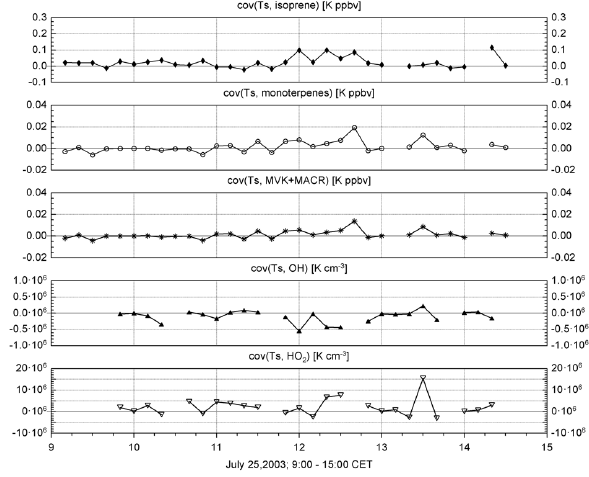
Fig. 9. Covariances ( T 0 s c 0 i ) with c 0 i = isoprene, sum of monoterpenes, MVK + MACR, OH and HO 2 at 37m height for 25 July 2003, 09:00–15:00CET.